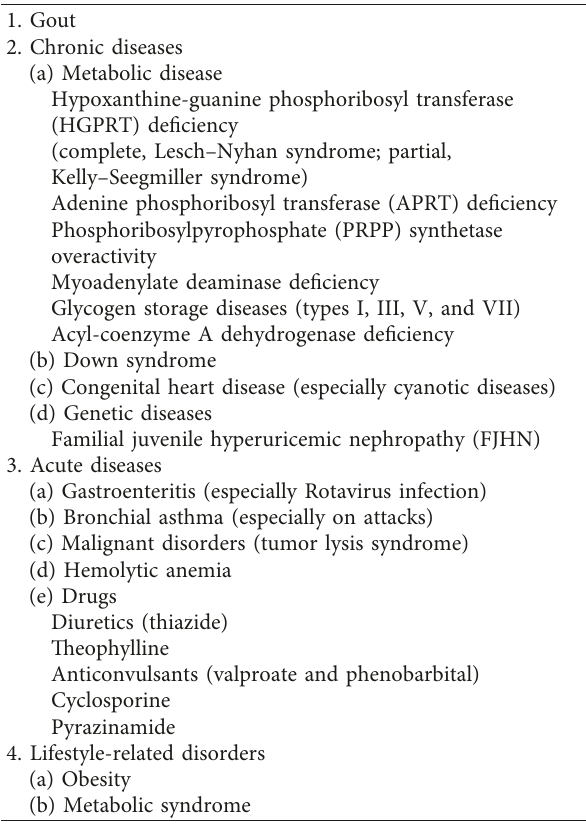
Table 2: Diseases/disorders causing hyperuricemia in children and